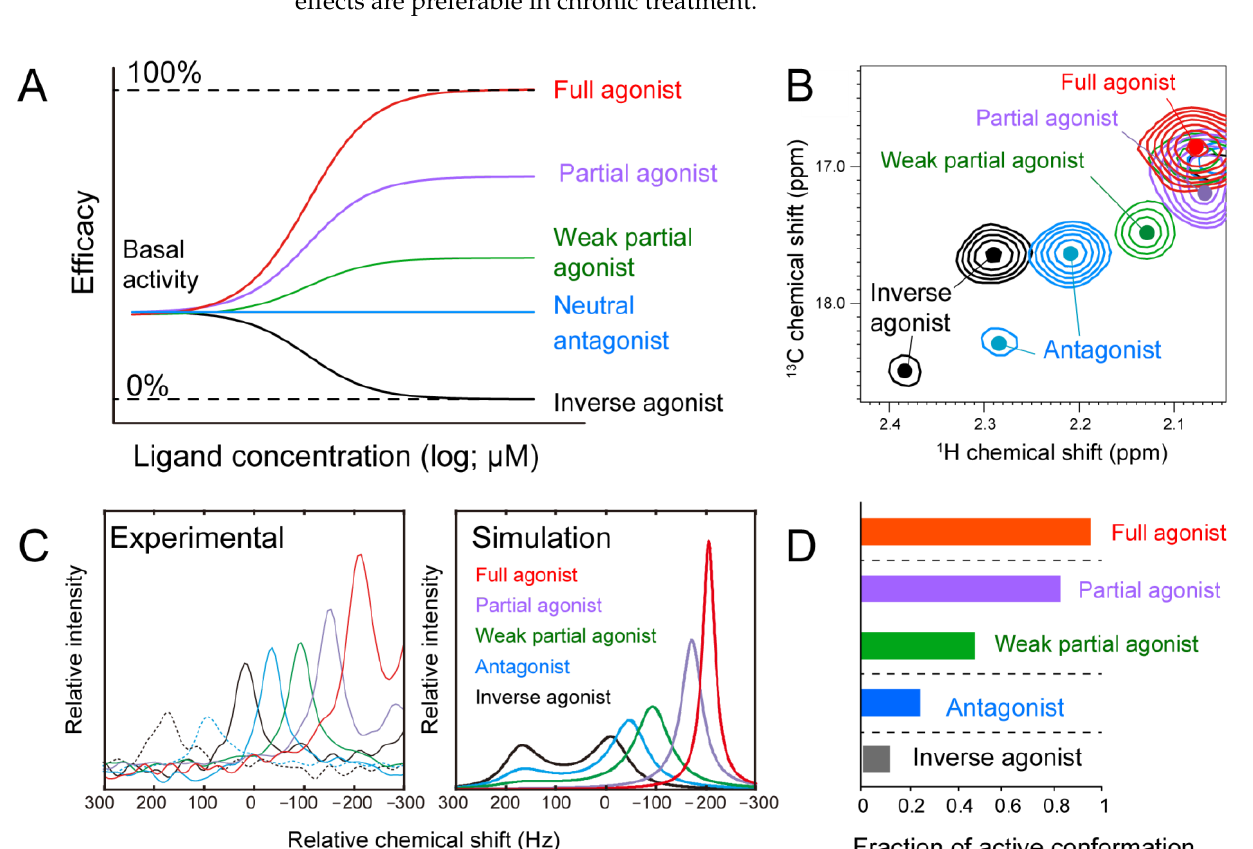
Figure 2. Efficacy of GPCR elucidated by NMR. ( A ) Pharmacological concepts of efficacy. ( B ) Overlay of the 1 H – 13 C SOFAST- HMQC spectra of [α,β,β - 2 H 3 -, methyl- 13 C- Met]β2AR at 298 K in complex with an inverse agonist, carazolol (black), a neutral antagonist, alprenolol (cyan), a weak partial agonist, tulobuterol (green), a partial agonist, clenbuterol (violet), and a full agonist, formoterol (red). Only the regions with M82 resonances are shown. The signals are color-coded in the same way as in panel ( A ). ( C ) Experimental (left) and simulation (right) spectra of the ligand-dependent shift of the M82 resonances. Overlay of the 1 H slice of M82 resonances in complexes with indicated ligands with different efficacy at 298 K is shown. ( D ) Conformational equilibrium quantified by NMR explains the efficacy of β2AR ligands. The fraction of active conformation that was obtained by fitting, shown in panel ( C ), was used. The figure was reproduced from [45] with permission.